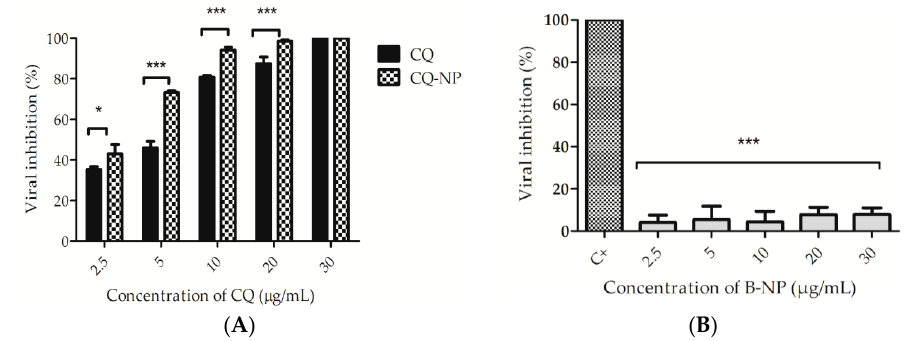
Figure 4. Antiviral activity of chloroquine (CQ), chloroquine loaded PLA nanoparticles (CQ-NP), and blank nanoparticles (B-NP). ( A ) Viral inhibition percentage after treatment for 48h with CQ and CQ-NP; and ( B ) viral inhibition percentage after treatment for 48h with B-NP. The positive control (C + ) of all experiments was acyclovir (20 µg mL − 1 ). Notes: The data were expressed as mean ± standard deviation (SD) ( n = 3), (*): p < 0.05 and (***): p < 0.001. The experiments were analyzed by the